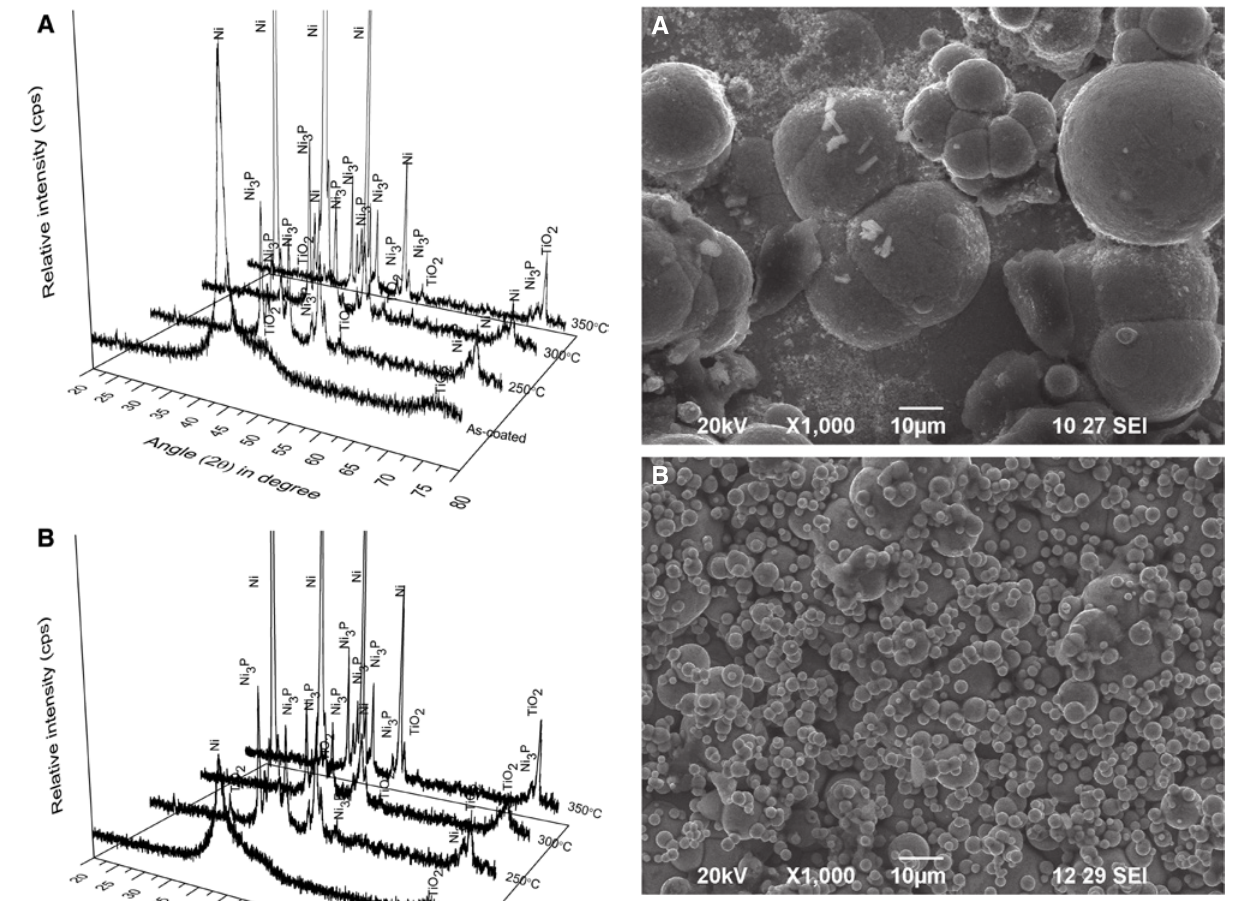
Figure 3 (A) SEM image of the as-plated Ni-P-TiO